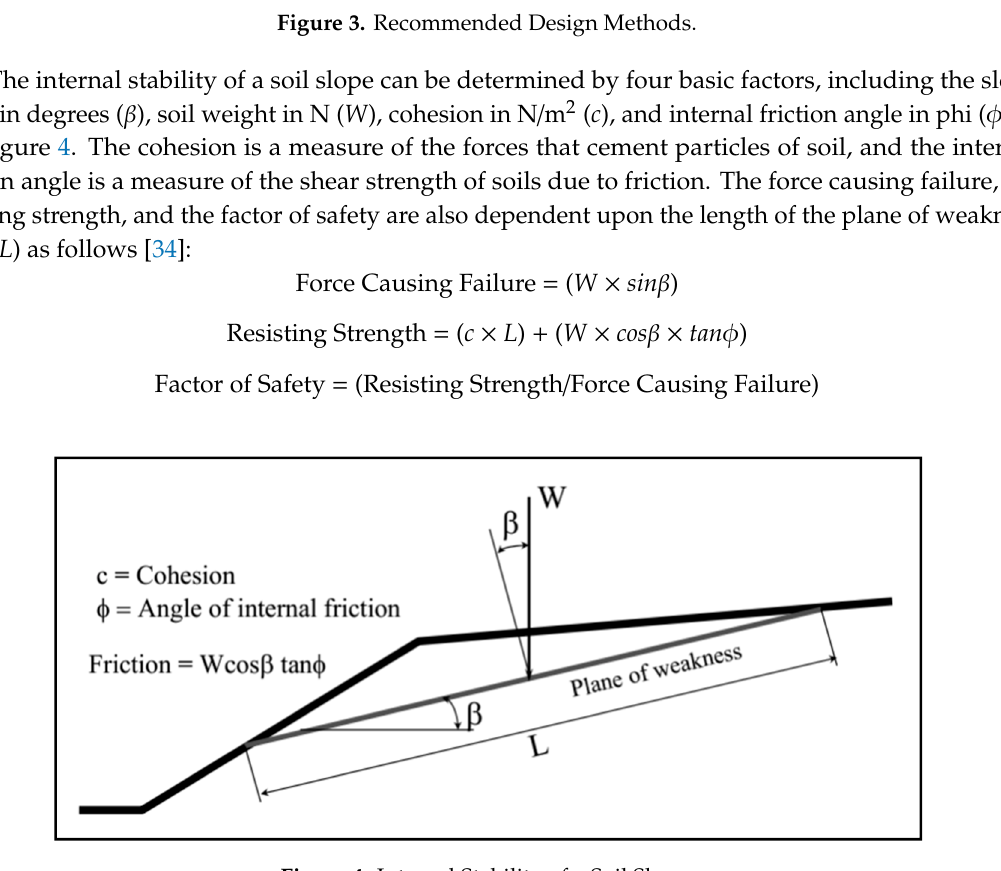
Figure 4. Internal Stability of a Soil Slope.